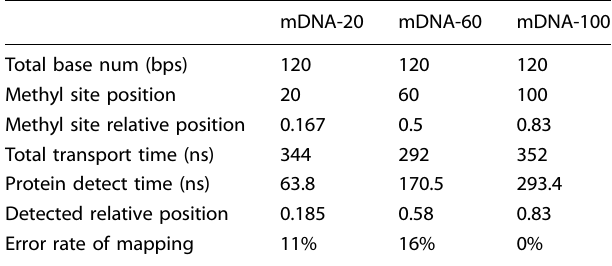
Table 1. Summary of methylation mapping performance of